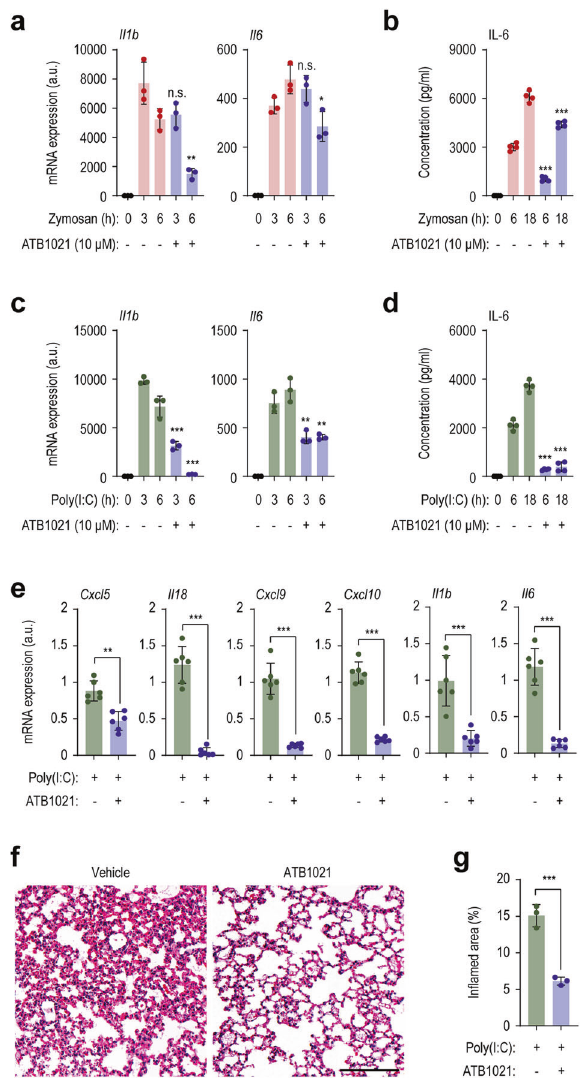
Fig. 3 A p62 ligand exerts inhibitory effects against various innate stimuli. a – d PMs were pretreated with ATB1021 (10 μ M) for 1 h and stimulated with zymosan (10 μ g/mL; a , b ) or poly(I:C) (10 μ g/mL; c , d ) for the indicated times; they were then analyzed by quantitative RT ‒ PCR to determine the mRNA levels of Il1b and Il6 ( a , c ; n = 3) or by ELISA to determine the protein level of IL-6 ( b , d ; n = 4). e